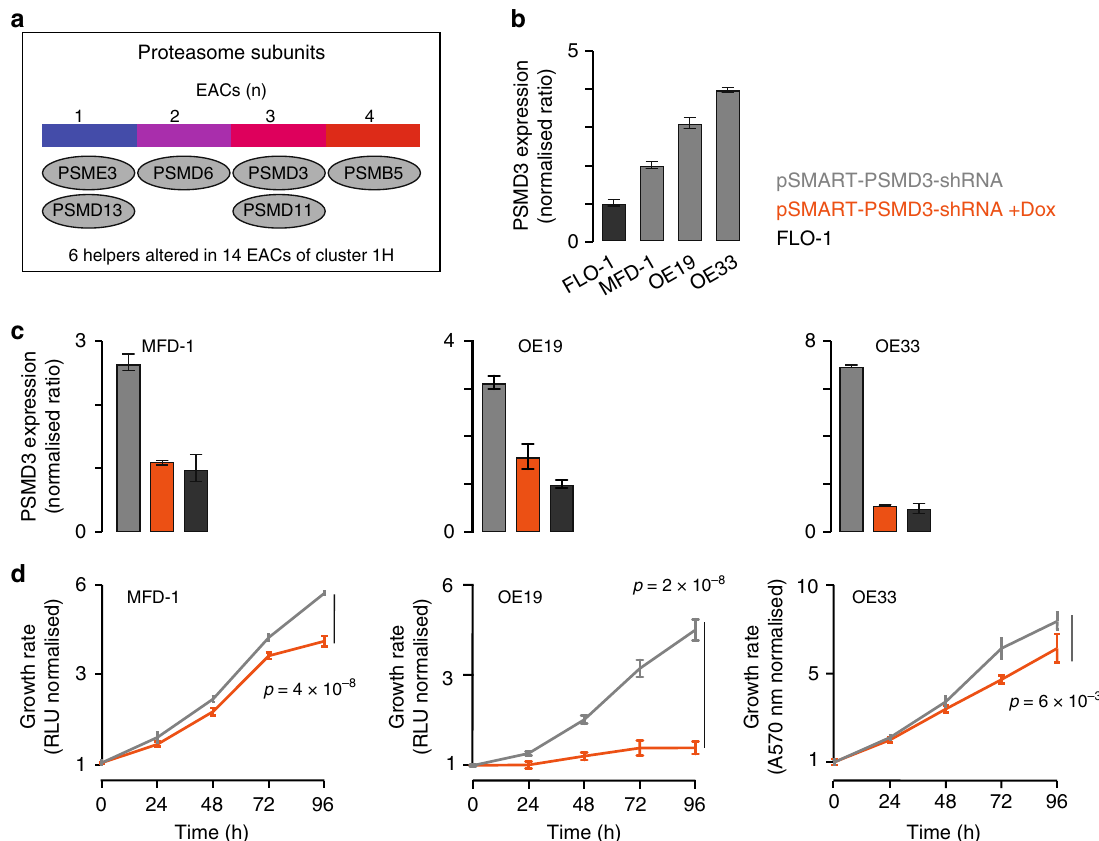
Fig. 6 EAC cell dependence on PSMD3 alteration. a Heatmap of proteasome subunits predicted as helpers in 261 EACs. b PSMD3 basal mRNA expression levels in FLO-1, MFD-1, OE19 and OE33 cells. Expression was relativised to β -2-microglobulin and normalised to FLO-1 cells. c PSMD3 expression levels in MFD-1, OE19 and OE33 after transduction with a lentiviral vector carrying an inducible shRNA against PSMD3 . Expression was assessed in the absence of doxycycline and after 96 h of doxycycline treatment, relativised to β -2-microglobulin and normalised to FLO-1 cells. d Proliferation curves of MFD-1, OE19 and OE33 cells with or without doxycycline treatment to reduce PSMD3 expression to levels comparable to those of FLO-1 cells. For all proliferation assays, n = 2 biological replicates were performed, each with four technical replicates. Proliferation was assessed every 24 h and each time point was normalised to time zero. Mean values at 96 h were compared by two-tailed Student ’ s t -test. All error bars show standard deviation. Source data are available in the Source Data fi